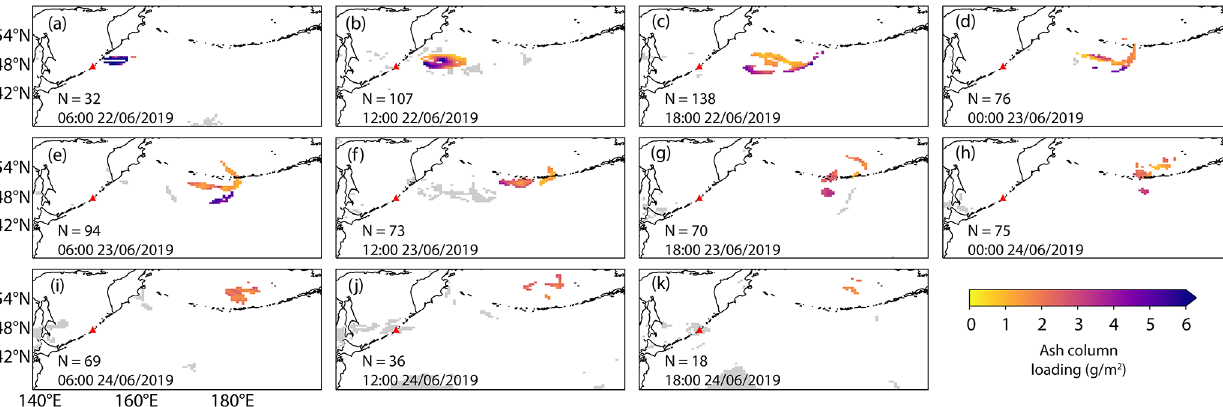
Figure 1. Hourly mean ash column loadings from the Himawari–8 satellite at (a) 06:00UTC, (b) 12:00UTC, (c) 18:00UTC on 22 June 2019, (d) 00:00UTC, (e) 06:00UTC, (f) 12:00UTC, (g) 18:00UTC on 23 June 2019, (h) 00:00UTC, (i) 06:00UTC, (j) 12:00UTC, (k) 18:00UTC on 24 June 2019. Grey shading indicates grid boxes that are classified as clear sky. The red triangle indicates the location of Raikoke. N indicates the number of grid boxes classified as containing ash. The same colour bar applies to all